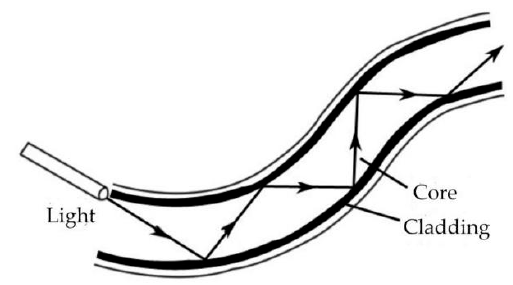
Figure 6. Schematic diagram of light propagation in fiber optic.